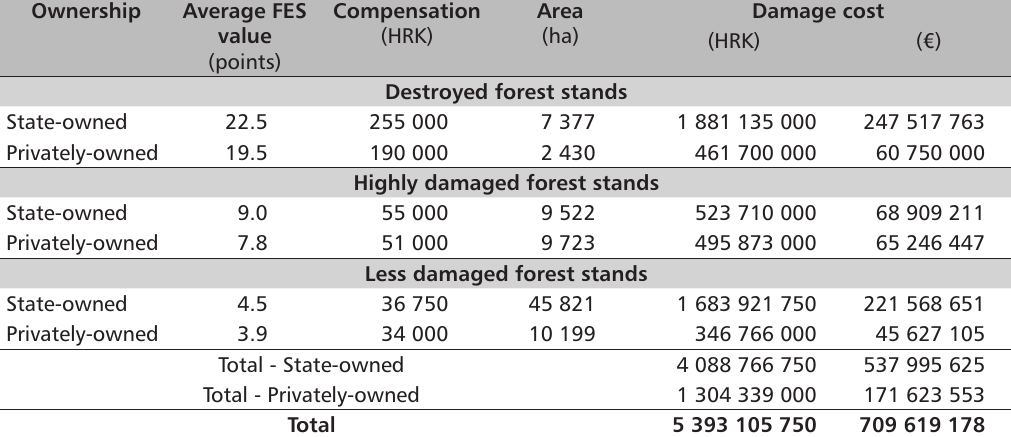
TABLE 5. Cost of damage of forest ecosystem services